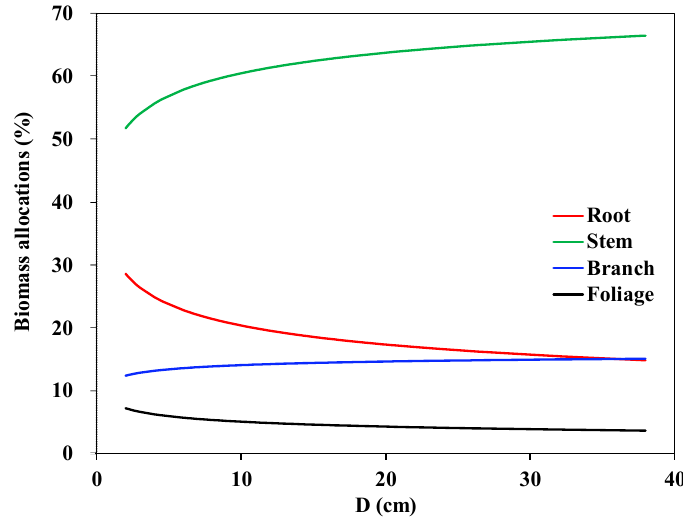
Figure 4. The relative proportion of biomass components estimated by the additive biomass model system developed in this study.